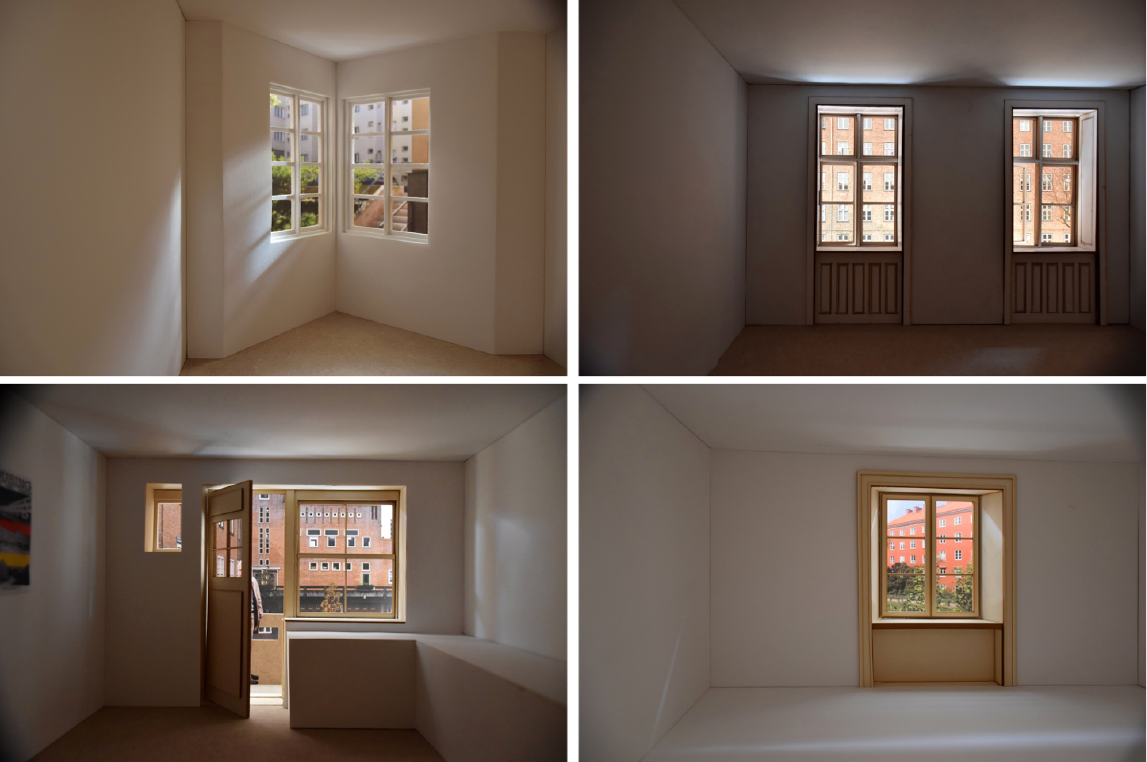
Figure 13. Selection of one-room scale model (clockwise order): Professor Jodl-Hof (Vienna), Hornbaekhus (Copenhagen), Rödabergsomradet (Stockholm) and Effen housing estate (Rotterdam). Source: